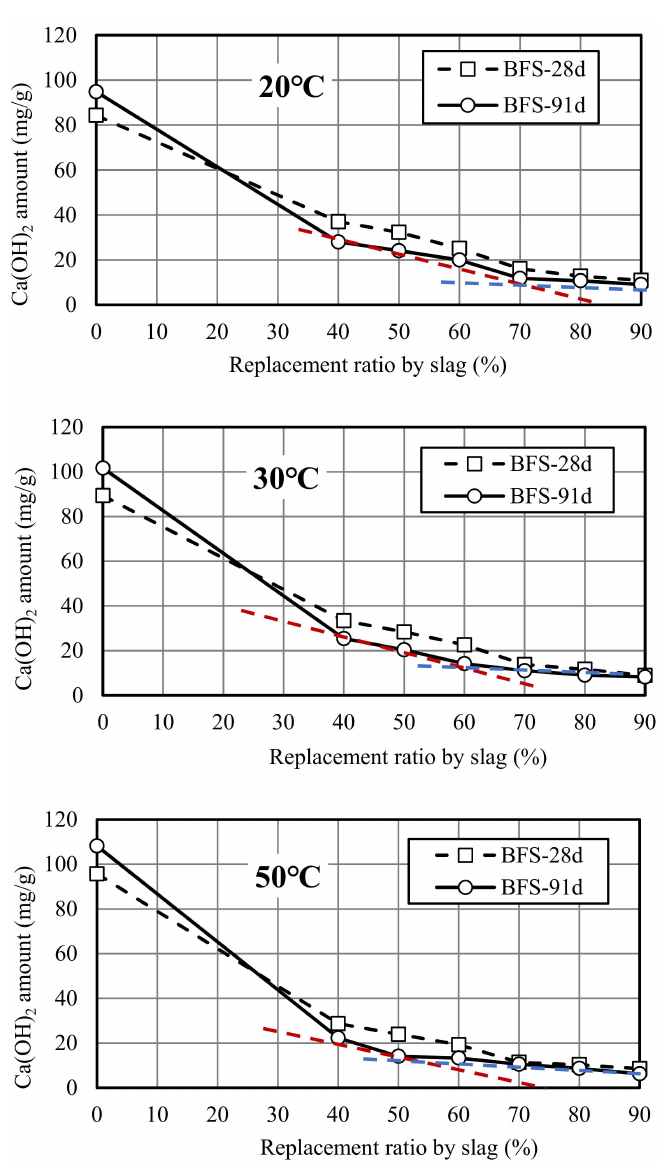
Figure 5. Amount of Ca(OH) 2 in slag mortar at di ff erent curing temperatures.